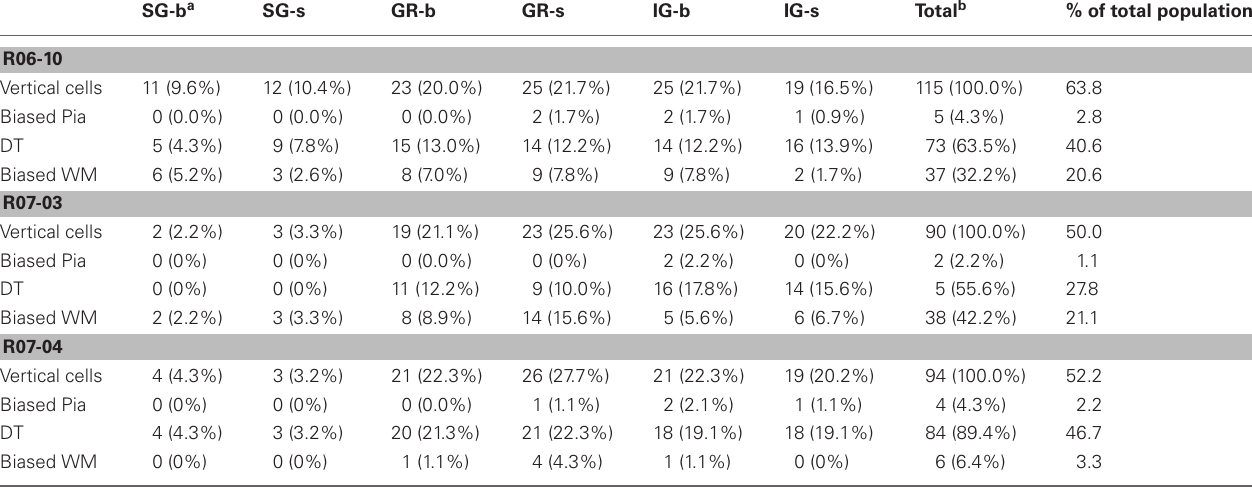
Table 3 | Distribution of different types of vertically-oriented nitrergic neurons across cortical compartments. SG-b